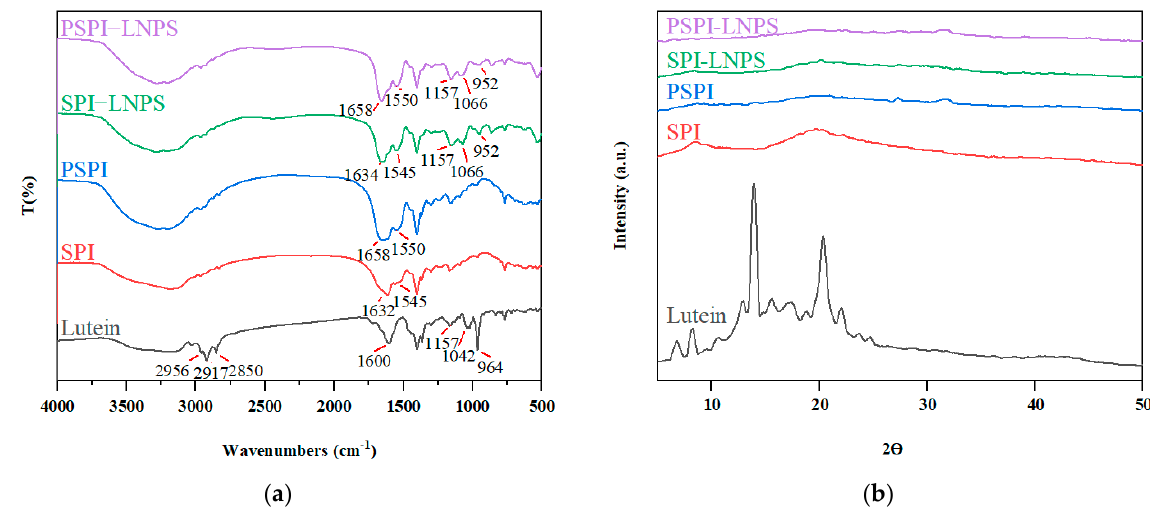
Figure 6. ( a ) FTIR spectra of lutein, SPI, and PSPI (2.5 mg/mL) in the absence and presence of lutein (0.07 mg/mL); ( b ) XRD spectra of lutein, SPI, and PSPI (2.5 mg/mL) in the absence and presence of lutein (0.07 mg/mL).